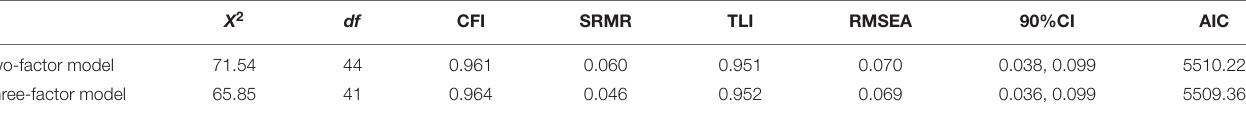
TABLE 4 | Confirmatory factor analysis of the